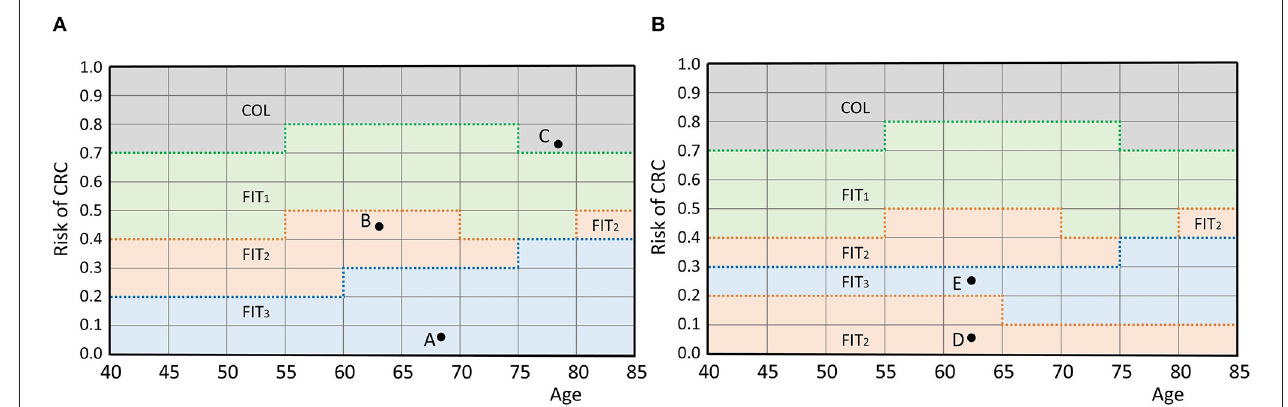
FIGURE 1 | (A) An example policy. Individuals are represented by a pair (age, perceived risk) which is a point in the belief space. For example, the participant represented by A is aged 68 and has a risk of 0.075. A policy defines an action for each individual by partitioning the belief space and relating each part to an action, as shown by the colors. The individuals represented by points A and B are prescribed actions FIT 3 and FIT 2 (a screening interval of 3 and 2 years), respectively. Individual C is referred to a hospital for a colonoscopy. The discretization of R and T causes the grid structure. (B) An infeasible policy. Participant E is assigned a longer interval than participant D while they are of the same age and the risk of E is higher. Therefore, this policy does not comply with the test order